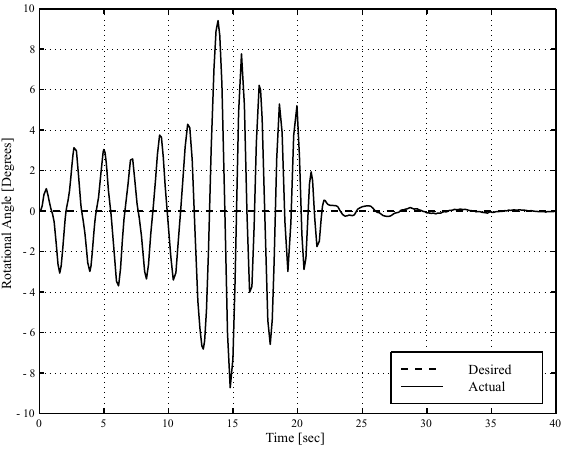
Fig. 28. Desired and actual rotational angles for the damping case using the fuzzy